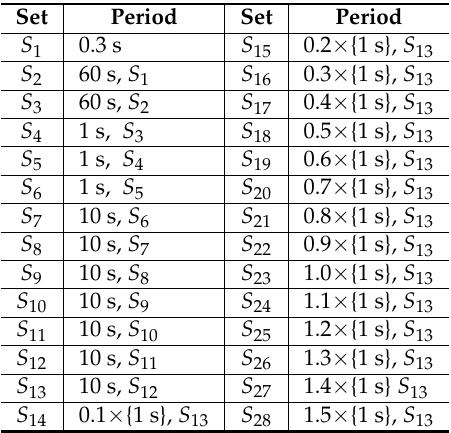
Table 4. Scenario 2 evaluation SmartData